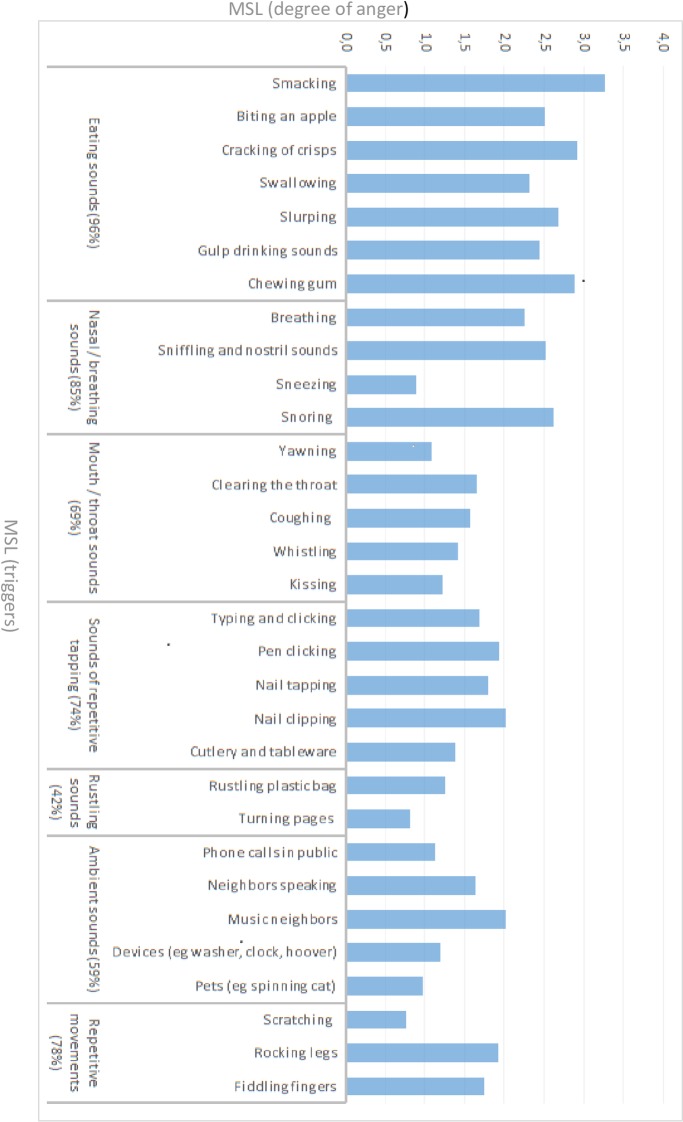
Triggers and provoked anger for misophonia subjects.